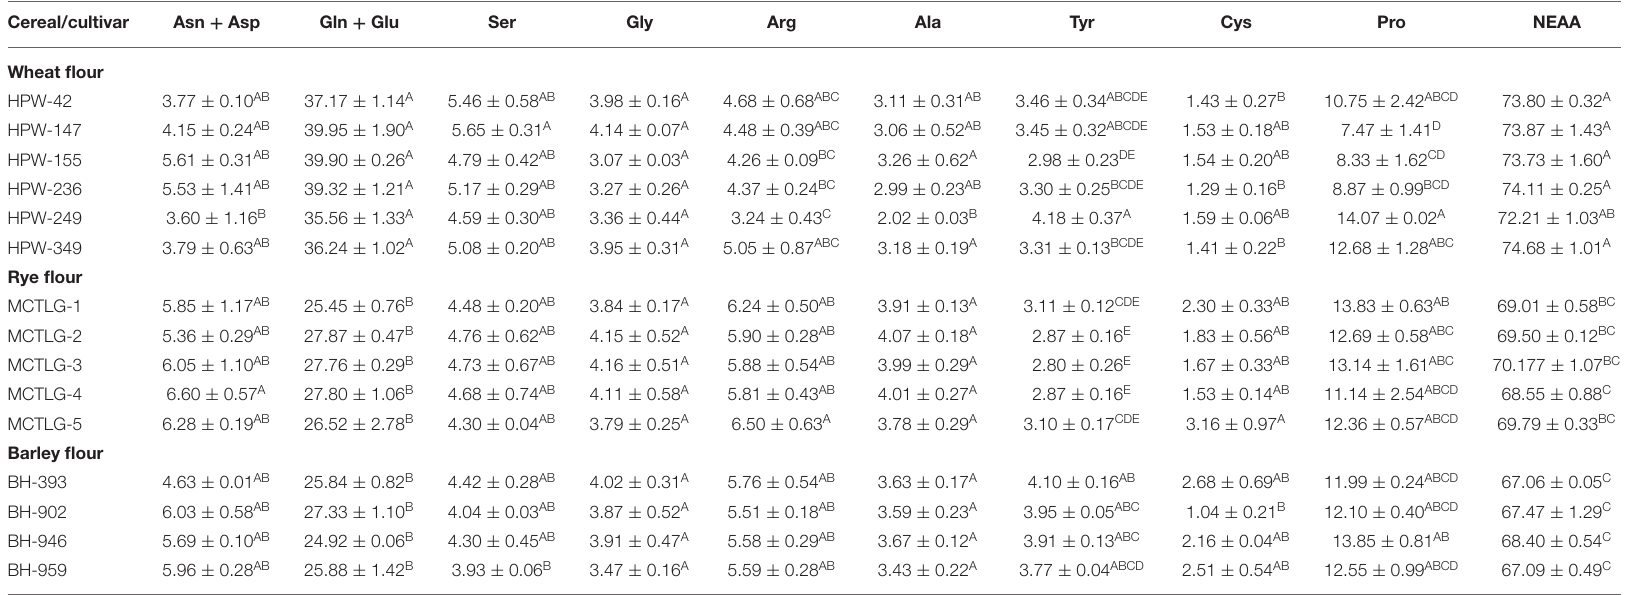
TABLE 5B | Non-essential amino acid (NEAA) composition (g amino acid/100g protein) in flour of wheat, rye, and barley cultivars.